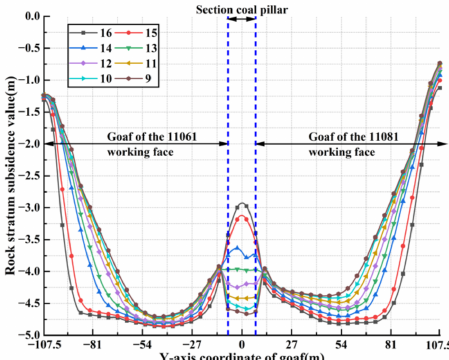
Figure 9. Subsidence values of overlying strata in the dip model of the GFST.